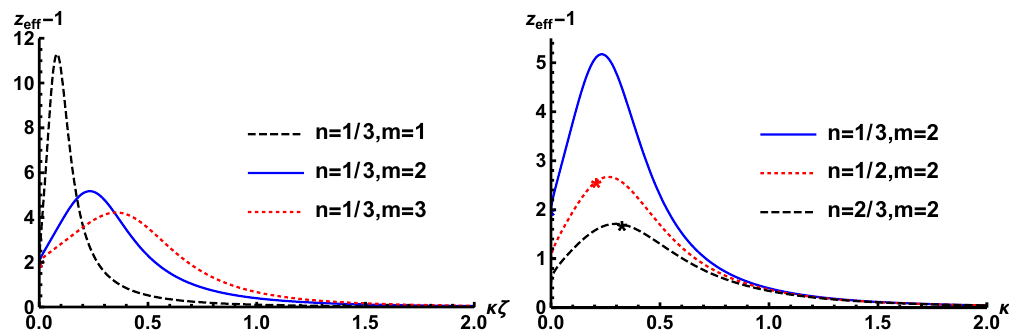
Figure 2 . Plots of z e(cid:11) ( (cid:16) ) (cid:0) 1 for di(cid:11)erent anisotropic Lifshitz solutions for Q f = 1. Left: we depict z e(cid:11) ( (cid:16) ) (cid:0) 1 for n = 1 = 3 and m = 1 (dashed black), m = 2 (blue), and m = 3 (dotted red). Right: we plot the case m = 2 with varying n = 1 = 3 (blue), n = 1 = 2 (dotted red), and n = 2 = 3 (dashed black). The maximal exponent decreases for increasing m or n .